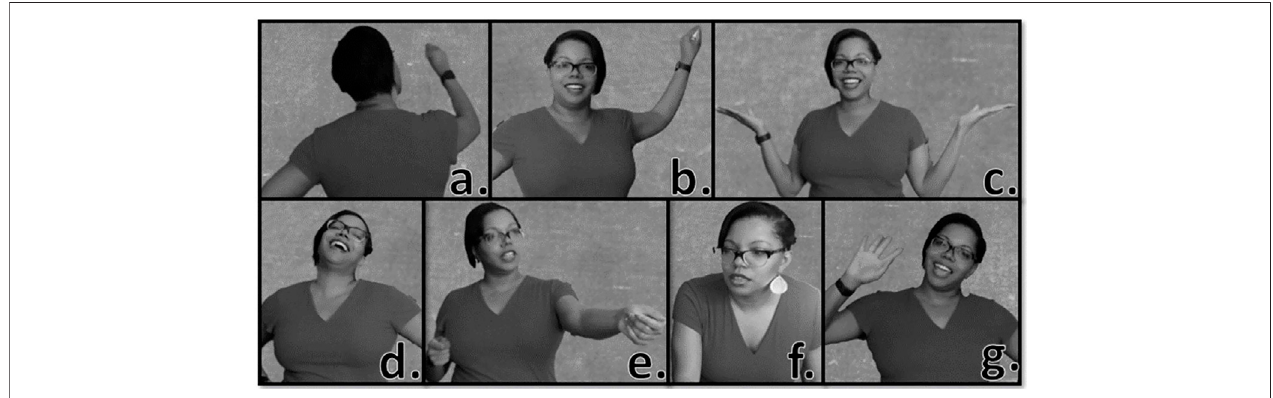
FIGURE 2 | Sample behaviors to guide SPBCS coding include (A) facing away from the interactant, (B) smiling, gaze, (C) gestures, (D) laughing, (E) calling on students, (F) using proximity, (G) and waving hello or goodbye. Coding behaviors and gestures should accompany coding of the participants utterances, as they frequently inform